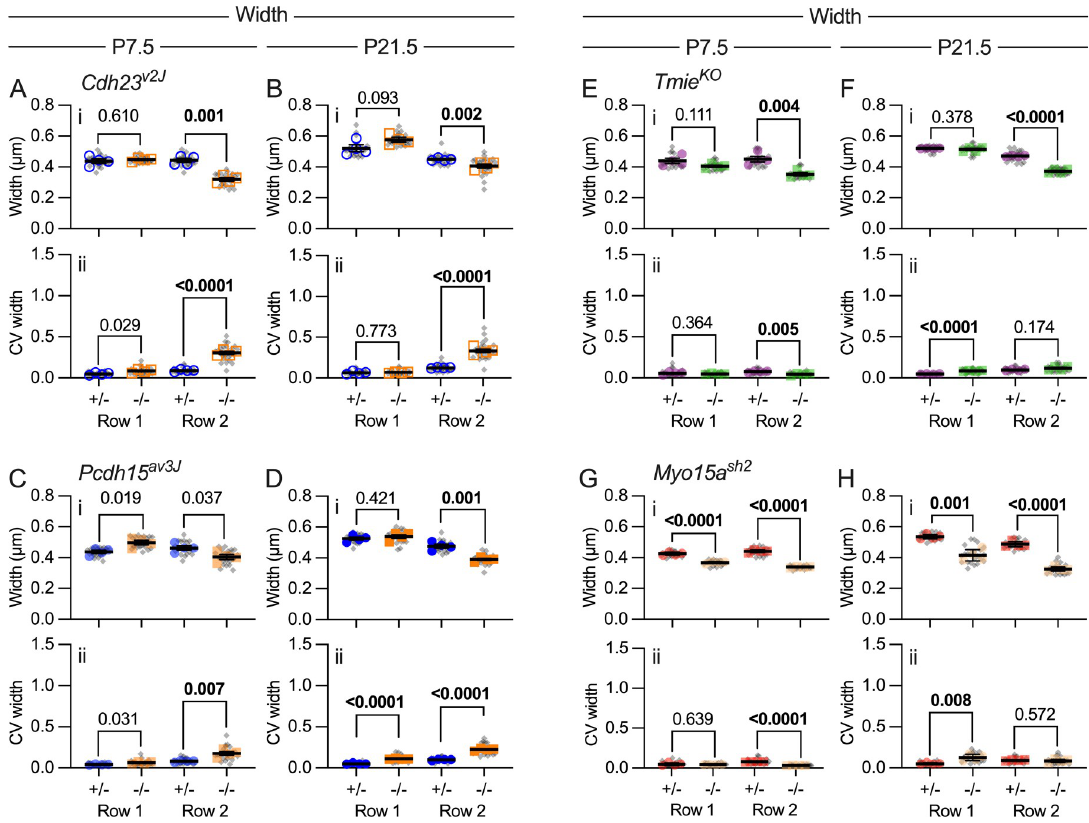
Fig 4. Stereocilia width in mutants. Width measurements used reconstructed stereocilia surfaces. ( A–H ) Average stereocilia width (panels labeled i) and CV (ii) were determined for the center 10 stereocilia of each hair cell (gray symbols), separately for rows 1 and 2. Plotting and statistical testing were as in Fig 3. ( A, B ) Width and width CV at P7.5 and P21.5 for Cdh23 v2J . ( C, D ) Width and width CV at P7.5 and P21.5 for Pcdh15 av3J . ( E, F ) Width and width CV at P7.5 and P21.5 for Tmie KO . ( G, H ) Width and width CV at P7.5 and P21.5 for Myo15a sh2 . The data underlying all the graphs shown in the figure can be found in figshare (https://doi.org/10.6084/m9. figshare.21632636.v2). CV, coefficient of variation.